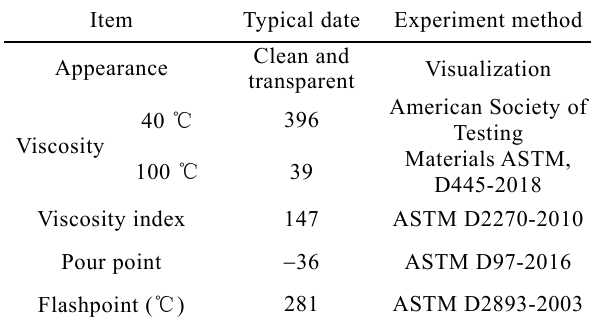
Table 1 Typical data of PAO.